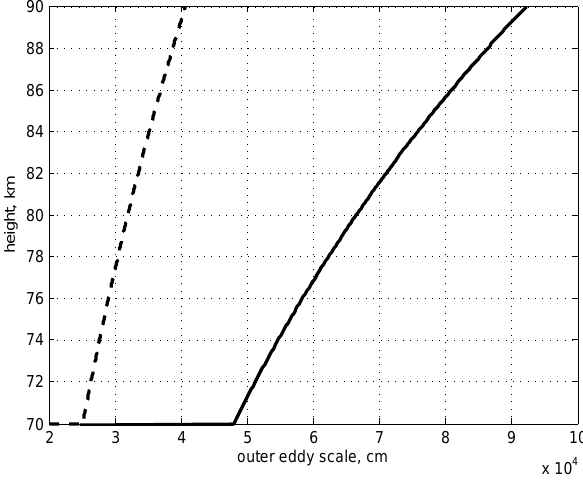
Figure 3. The height profiles of the outer scales of eddies L B in January (dashed curve) and September (solid curve) calculated using the data on ε and K ed shown in Fig. 1 in Sasi and Vi- jayan (2001): ε 0 = 31.6erg/(gs) and K ed0 = 1 × 10 5 cm 2 s − 1 for January and ε 0 = 75erg/(gs) and K ed0 = 3 . 16 × 10 5 cm 2 s − 1